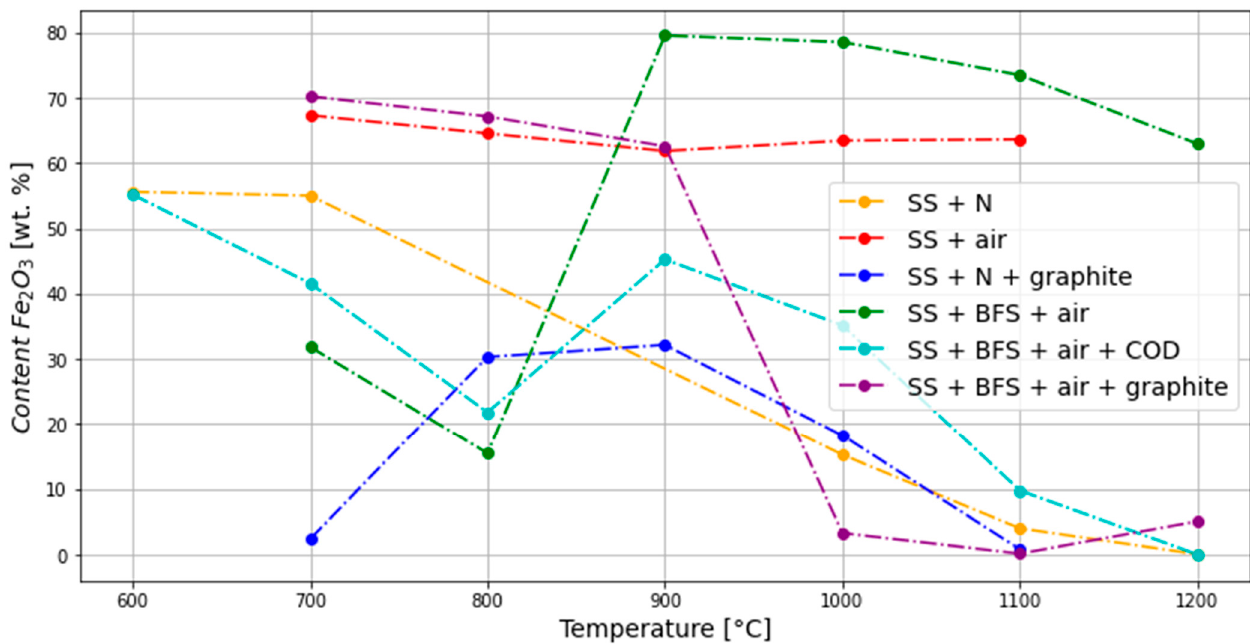
Figure 3. Effect of temperature, atmosphere and reducing element on Fe 2 O 3 content in sludge. The fluctuation of the values is visible in the case of SS+BFS+air+COD, however, reaching the key temperature above 900 ◦ C, the content of observed oxide is getting comparable trend as other combination of agents it is gradually dropping. The decrease in the Fe 2 O 3 content occurred in individual batches with a simultaneous increase in the FeO content (Figure 4), and primarily with a simultaneous increase in the Fe metallic content (Figure 5).